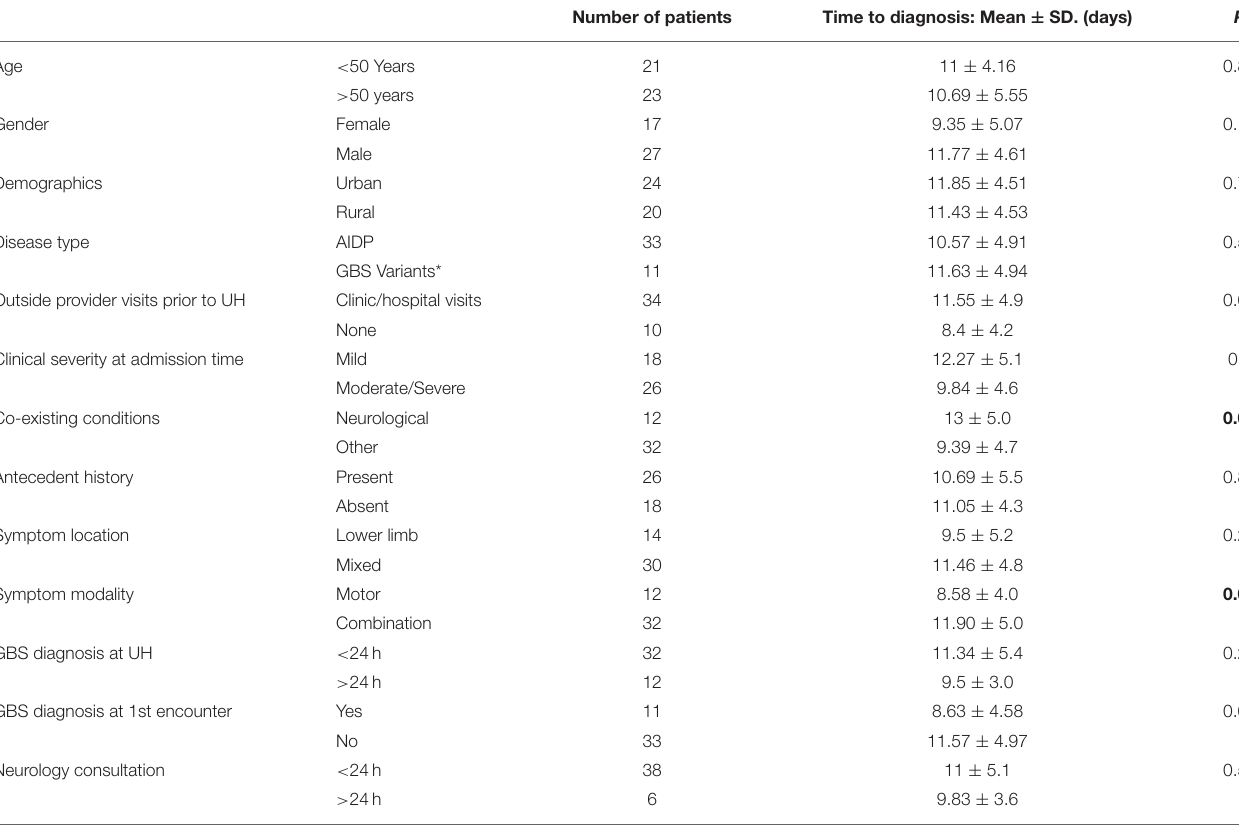
TABLE 2 | Comparative analysis of mean time to diagnosis across all identified variables.